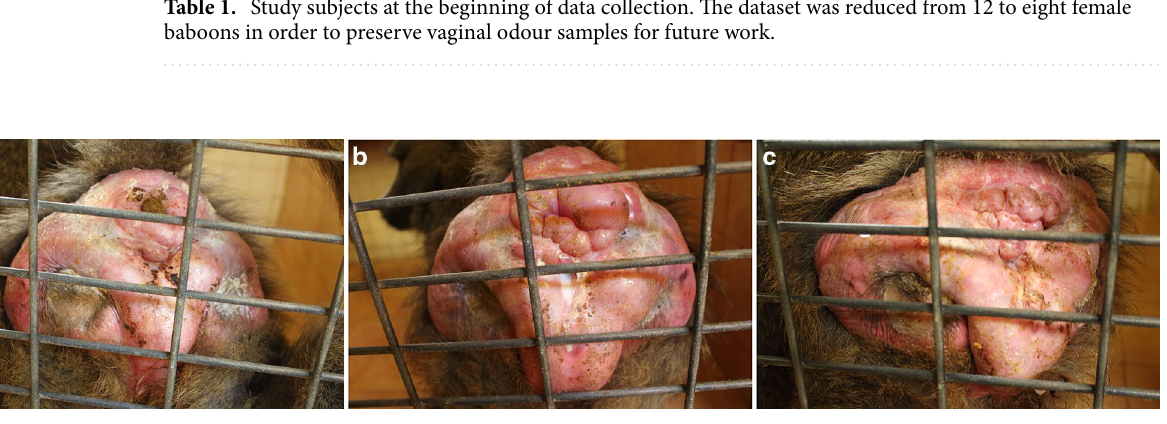
Figure 1. Pictures of moderate ( a ), large ( b ) and deflating ( c ) genital swellings of the same female baboon across her menstrual